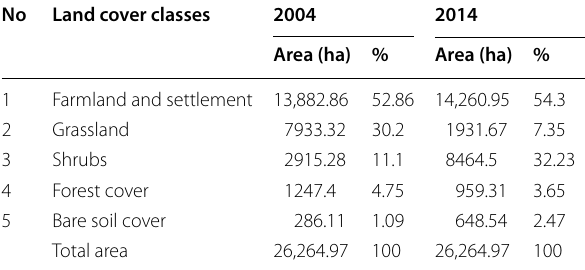
Table 3 Land use and cover patterns of Gelda catchment between 2004 and 2014, Northwestern highlands of Ethiopia